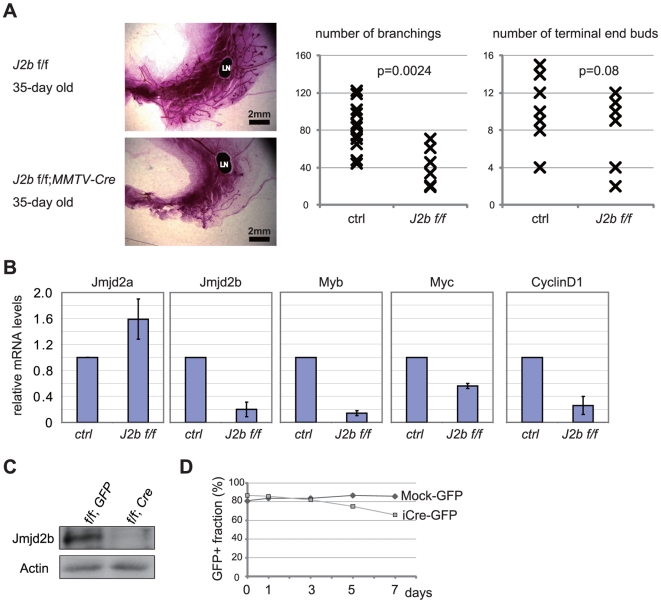
Conditional deletion of Jmjd2b in mammary epithelium results in defective mammary gland development.(A) Defective development of Jmjd2b-deficient mammary gland. Carmine-stained whole-mount preparations of mammary glands from 5-week old Jmjd2b
flox/flox;MMTV-Cre and Jmjd2b
flox/flox mice (Ctrl∶control). Representative littermates are shown. LN, lymph node. The numbers of branching and terminal end buds within a fat pad were determined (Jmjd2b
flox/flox n = 11; MMTV-Cre;Jmjd2b
flox/flox: n = 6). (B) Impaired gene expression in Jmjd2b
flox/flox; MMTV-Cre MECs. Lin− MECs were isolated from Jmjd2b
flox/flox;MMTV-Cre and Jmjd2b
flox/flox mice. mRNA levels of Jmjd2b, Myb, CyclinD1 and c-myc were examined by real-time RT-PCR. Results represent mRNA levels normalized to the level of Actb mRNA (mean ± s.d. of five independent littermate pairs). (C) Western blot showing the absence of Jmjd2b protein in Cre-infected Jmjd2b
flox/flox MECs. Full-length blots are in Figure S7 (D) Impaired proliferation of Jmjd2b-deficient MECs. Lin− MECs were isolated from Jmjd2b
flox/flox mice, infected with Mock-GFP or Cre-IRES-GFP (iCre-GFP) retrovirus, and cultured in vitro. Fractions of GFP-positive cells were determined at the indicated time points by FACS analysis. A representative result from three independent experiments is shown.